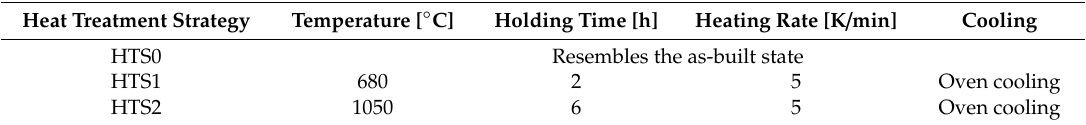
Table 3. Heat treatment strategies and corresponding parameters for tempering (HTS1) and coarse grain annealing